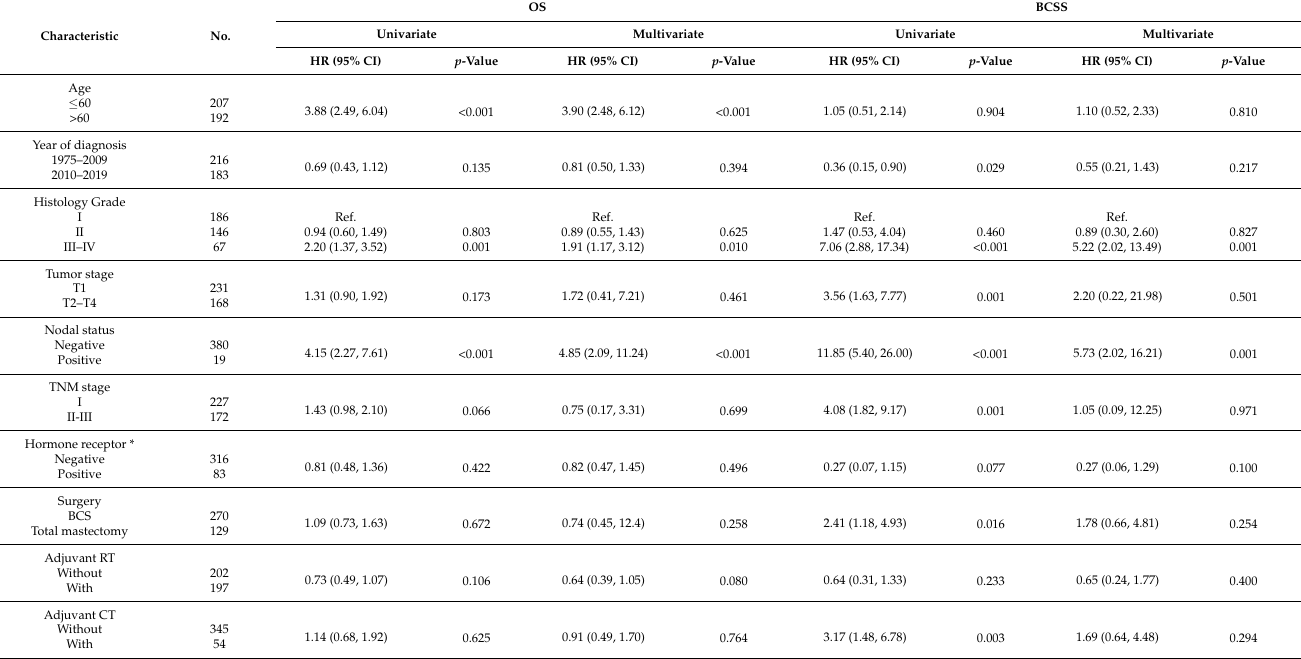
Table 2. Prognostic factors influencing the survival of patients with ACC of the breast (N =